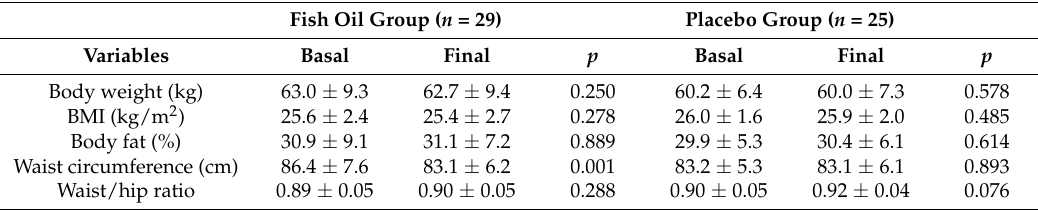
Table 1. Anthropometric measurements.